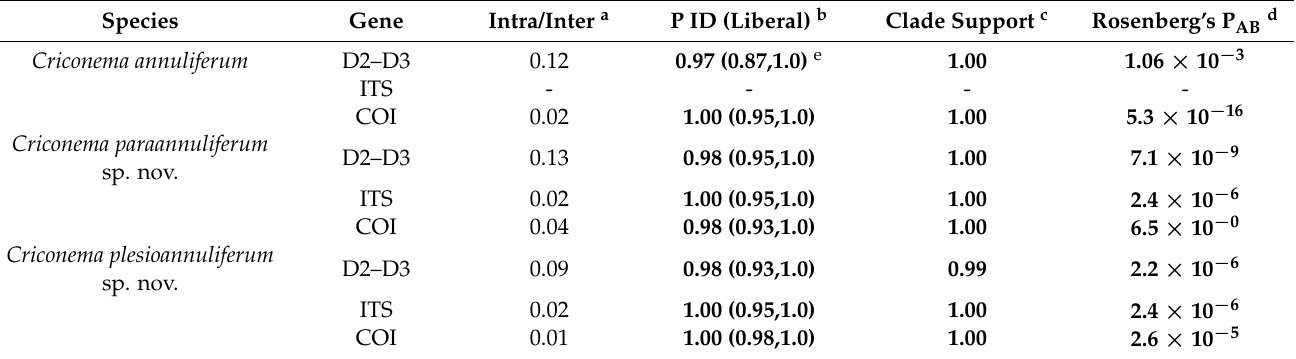
Table 3. Parameters evaluating the Criconema annuliferum -complex delimitation based on two rRNA genes (D2-D3 region of the 28S rRNA, ITS) and one mtDNA barcoding locus, COI for three Criconema species of the complex.